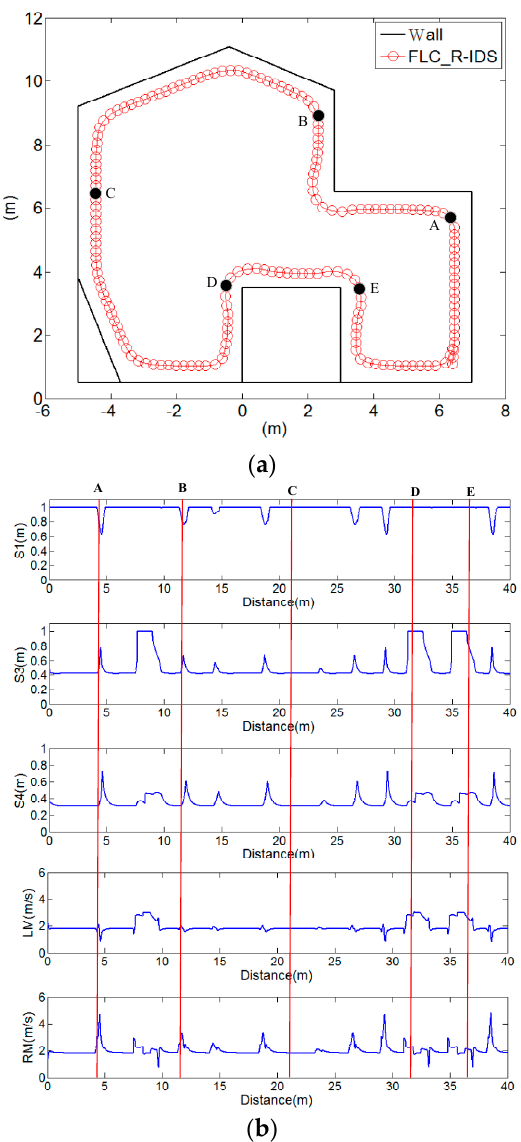
Figure 8. ( a ) Mobile robot path tracking, ( b ) ultrasonic sensor values and the left-wheel and right-wheel speeds of the robot in test environment 1 for the FLC_R-IDS method.